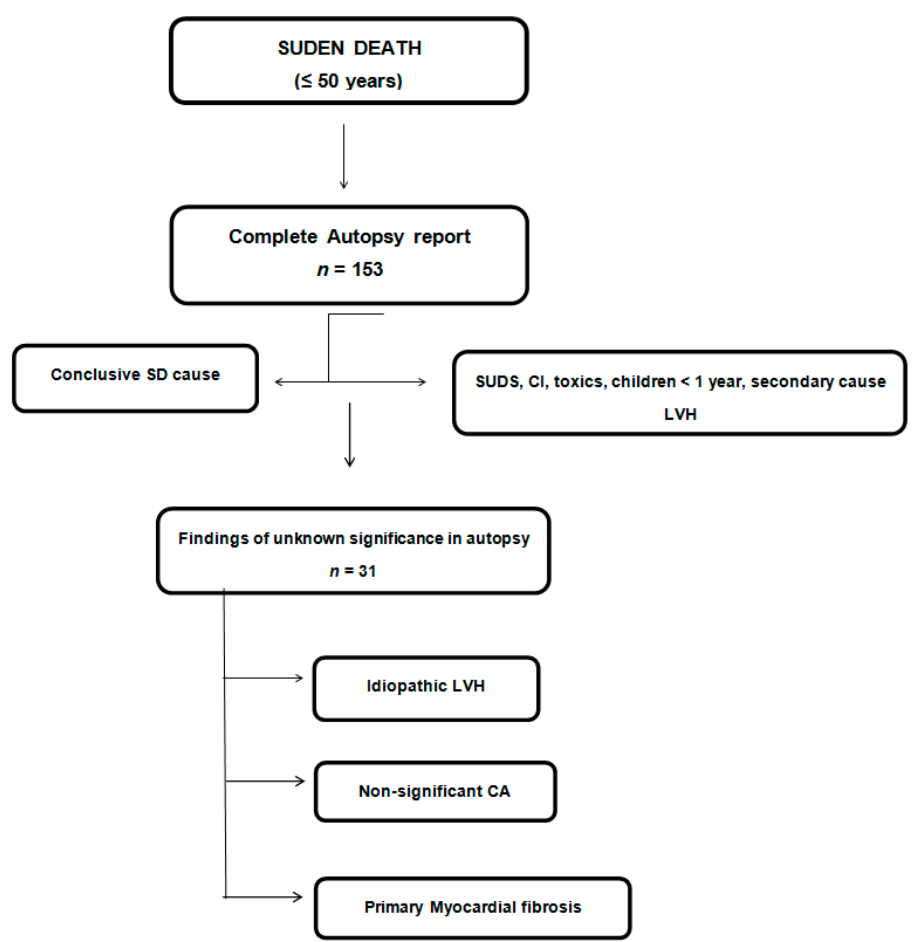
Figure 1. Flow chart of study cohort. SD, sudden death. SUDS, sudden unexpected death syndrome. IC, ischemic cardyomyopathy. LVH, left ventricular hypertrophy. CA, coronary athero- sclerosis.